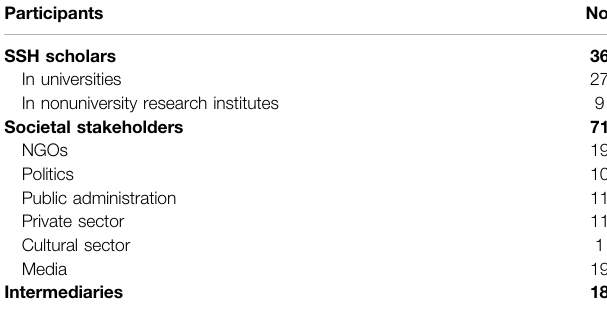
TABLE 1 | Sample of the online consultation by group